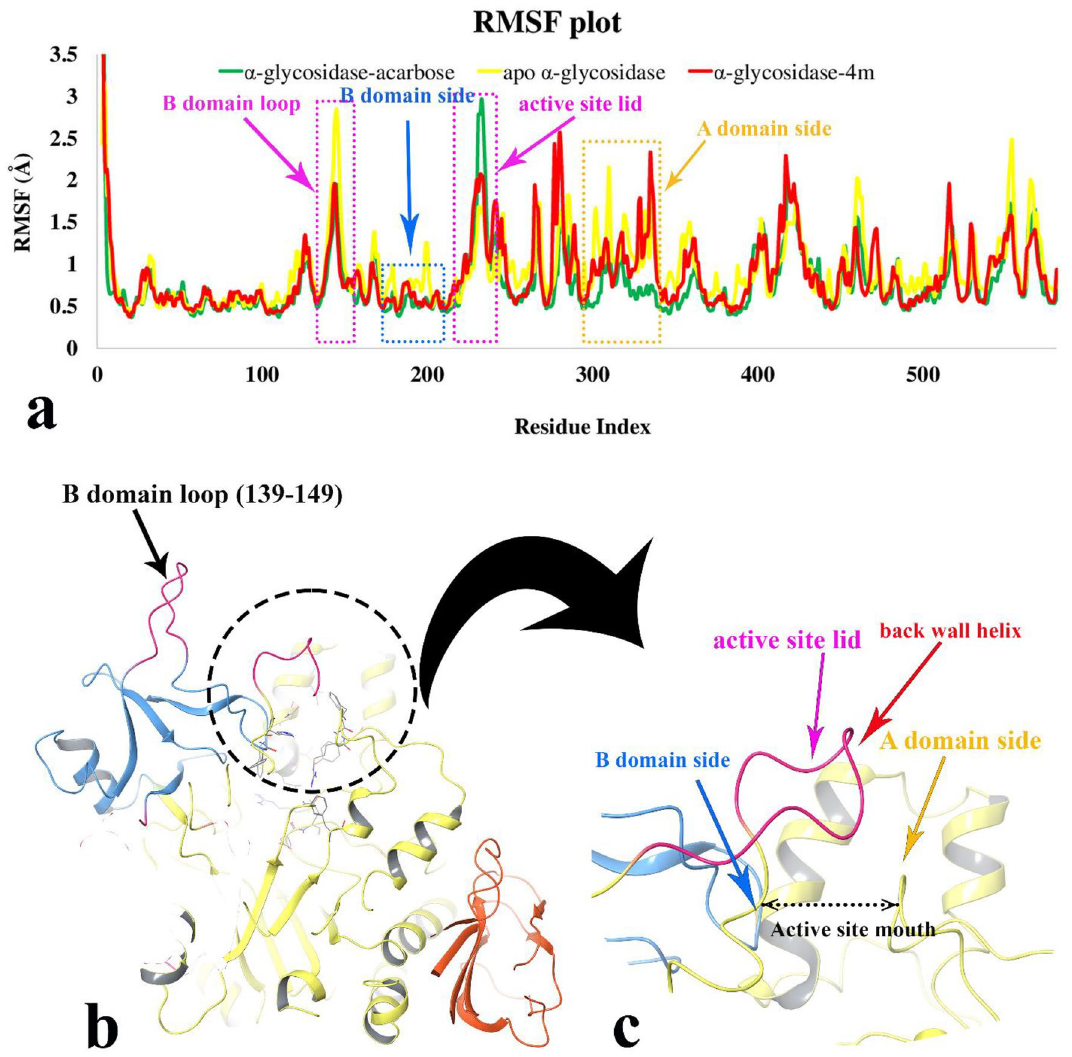
Figure 9. RMSF plot of the α-glycosidase backbone in complexed with compound 4m (in red), acarbose (in green) and the apo enzyme (in yellow) for over 60 ns MD simulation time ( a ). 3D representation of α-glycosidase structure. Enzyme domain of A, B and C are colored in yellow, blue, and orange, respectively. The flexible regions correspond to B domain loop and active site lid are colored in pink ( b ). Close-up representation of α-glycosidase active site ( c ) (Desmond